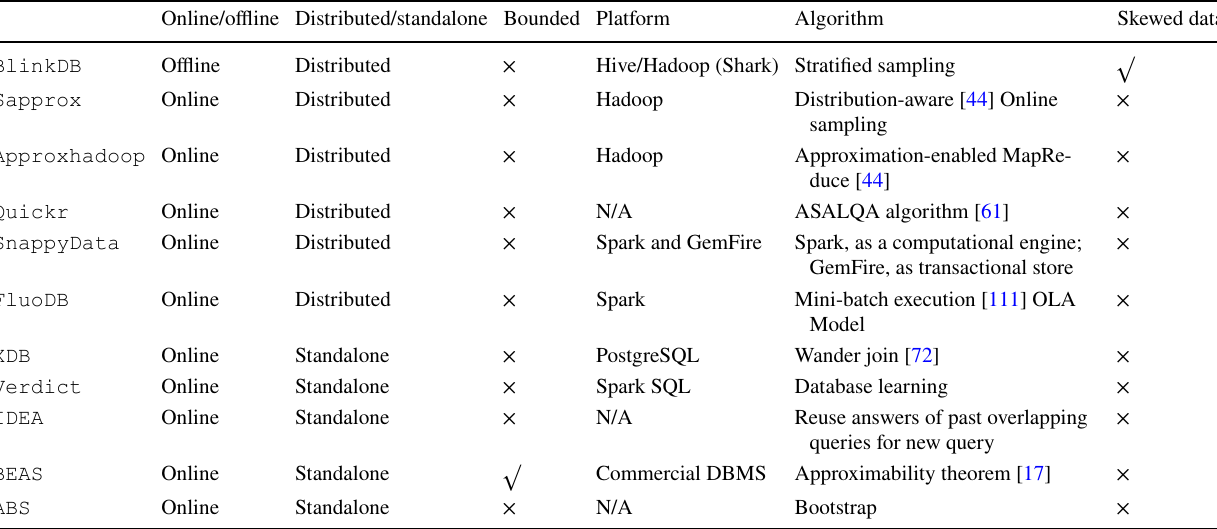
Table 2 Comparison of the AQP